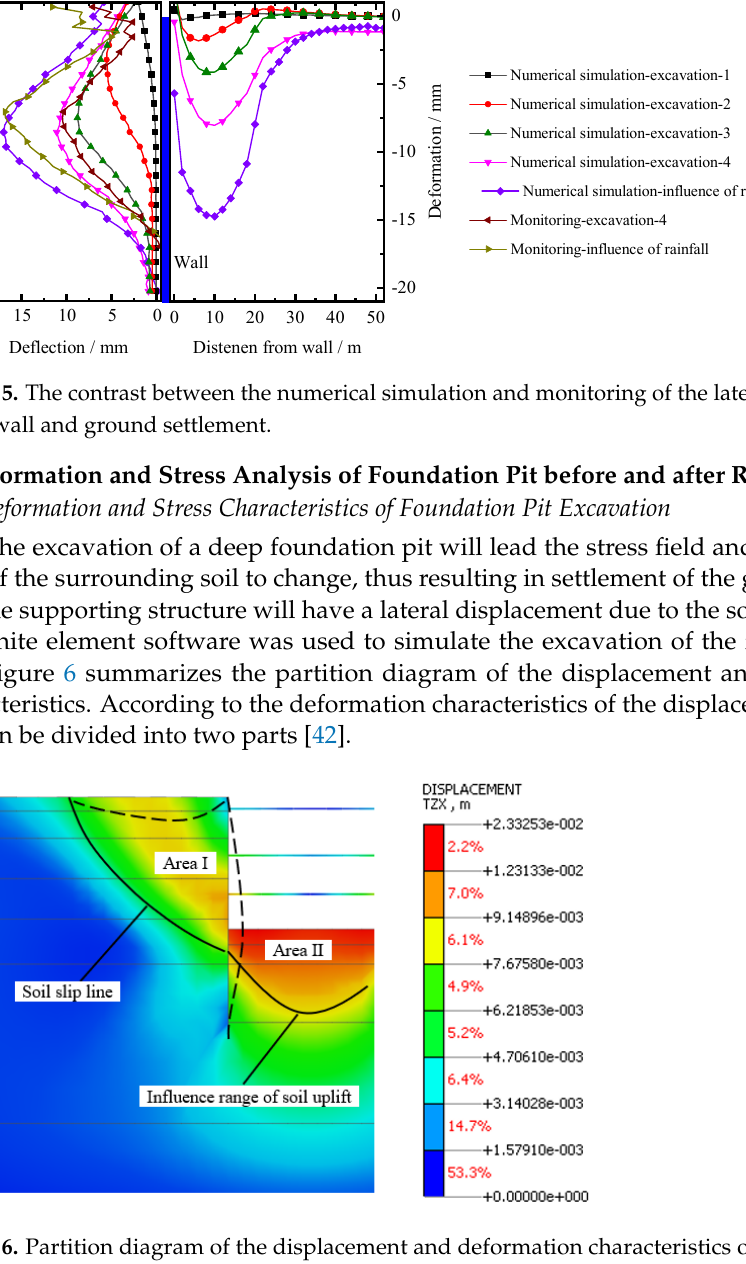
Table 3. The rainfall analysis condition.